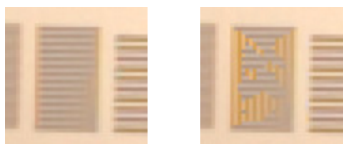
Figure 4. Artefact of the AHD algorithm. The maze-like structure on the right is an effect of the algorithm alternating between horizontal and vertical interpolation (G´o´zd´z,